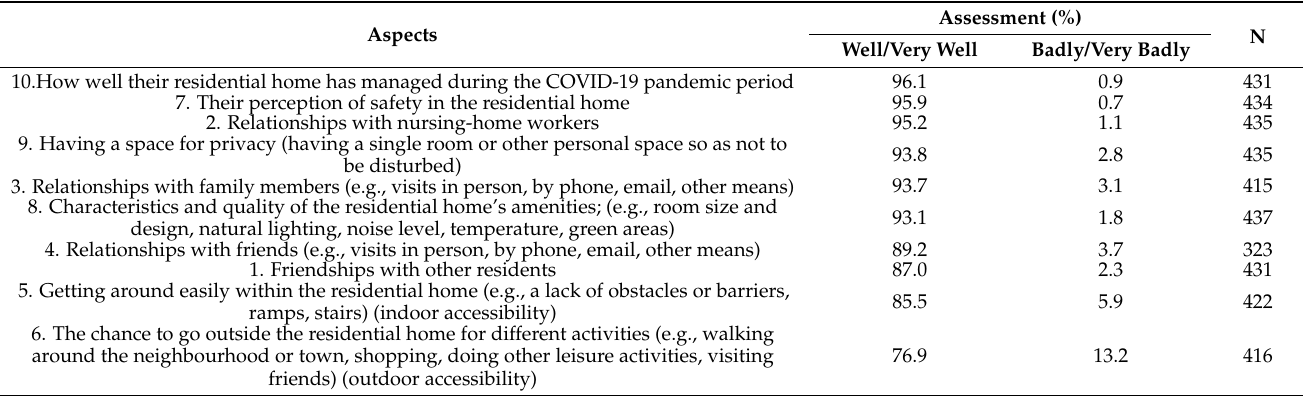
Table 1. Assessment of nursing-home aspects during the pandemic period (in descending order based on the good/very good response